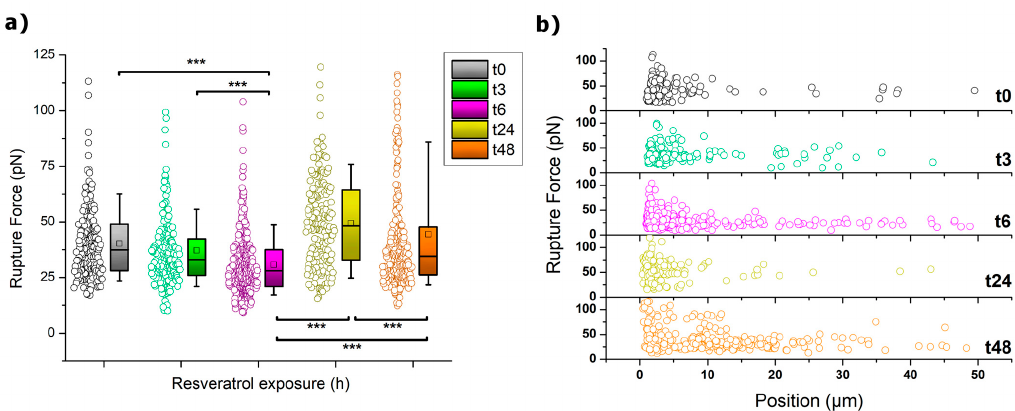
Figure 4. ( a ) Boxplot distribution of the rupture force values for MCF-7 cells. The square ( □ ) in the box plot represents the mean value, and the box-splitting horizontal line gives the median. Significance of the variations in the p < 0.001 level is indicated accordingly by (***) symbol. ( b ) Overall rupture event distribution in the shape of rupture force vs pulling (Z) distances.